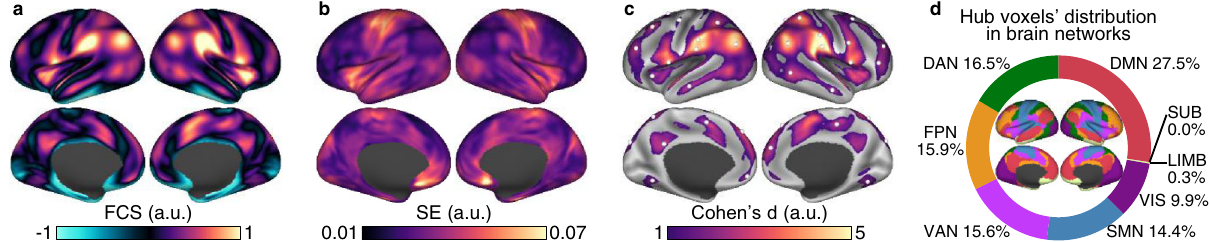
Fig. 1 Identifying consistent connectome hubs using a harmonized meta-analysis model. a , b Robust FCS pattern ( a ) and its corresponding variance (standard error, SE) map ( b ) estimated using a harmonized voxelwise random-effects meta-analysis across 61 cohorts. c The most consistent functional connectome hubs ( p < 0.001, cluster size > 200 mm 3 ). White spheres represent hub peaks. a – c a.u. arbitrary unit. d Hub voxels ’ distribution in eight large- scale brain networks. Insets depicts the seven large-scale cortical networks 29 . SUB subcortical network, LIMB limbic